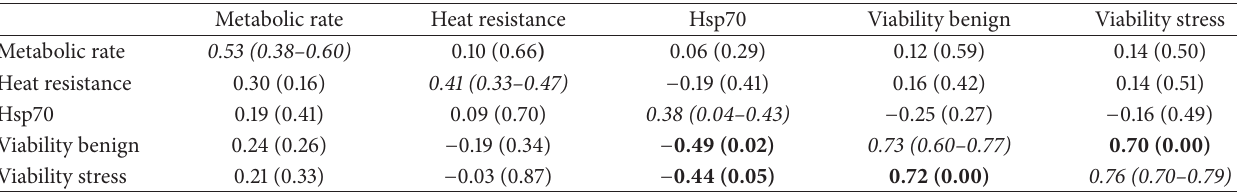
Table 1: Diagonal elements (italicized numbers) are estimated SNP heritabilities and the 95% bootstrap confidence interval in parentheses. Off-diagonal elements are genomic and raw phenotypic correlations. Below the diagonal are the Spearman rank correlations of genomic values ( ̂ g ) with associated 𝑝 values and above the diagonal are the Spearman rank correlations coefficients of line means with associated 𝑝 values. Numbers in bold are correlations with a 𝑝 < 0.05